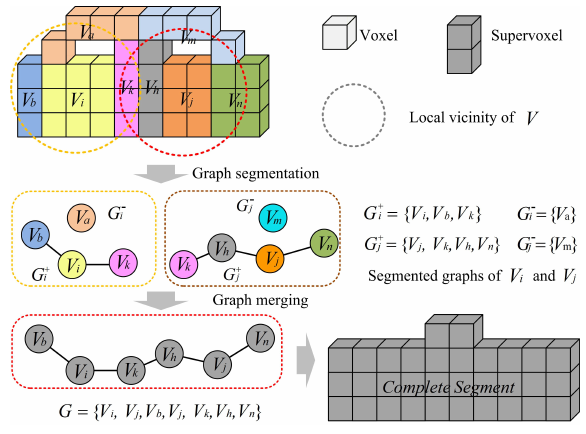
Figure 4. Aggregation of